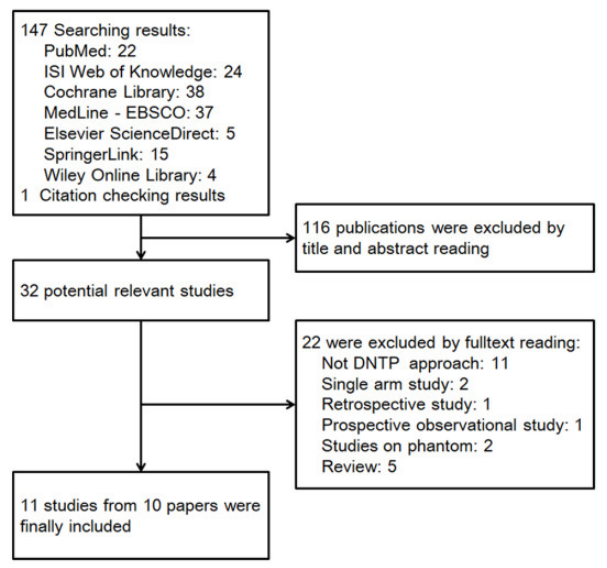
Figure 1. Flow diagram of selected studies.